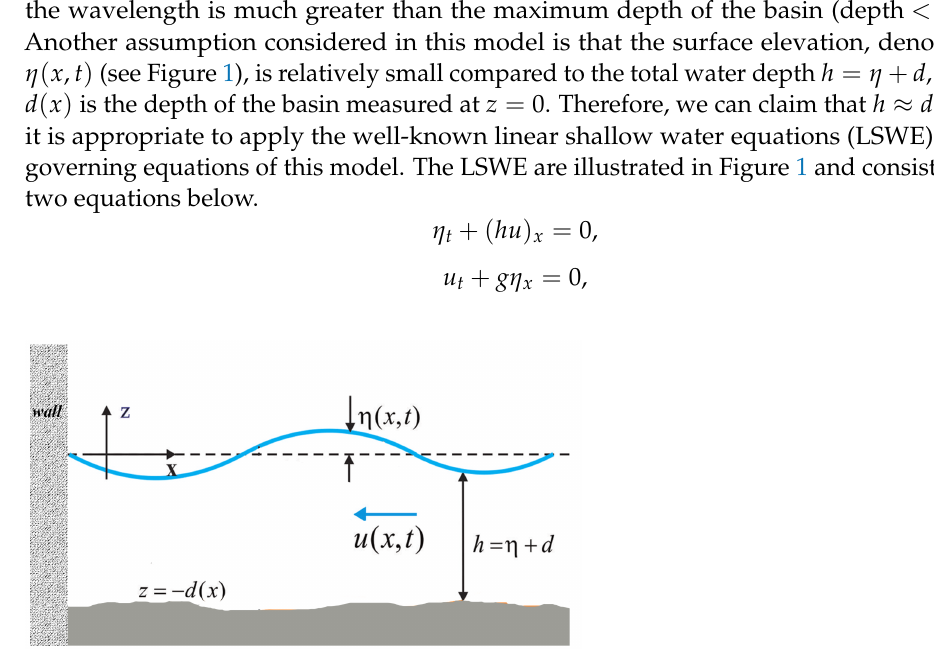
Figure 1. Description of the shallow water equations model in a semi-closed basin with arbitrary bottom